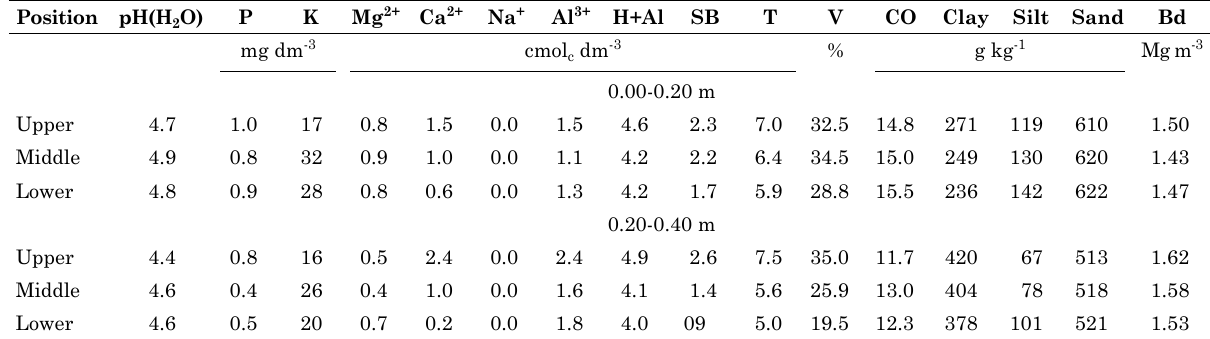
Table 1. Characterization of soil properties according to the sampling position in the slope Position pH(H 2 o)